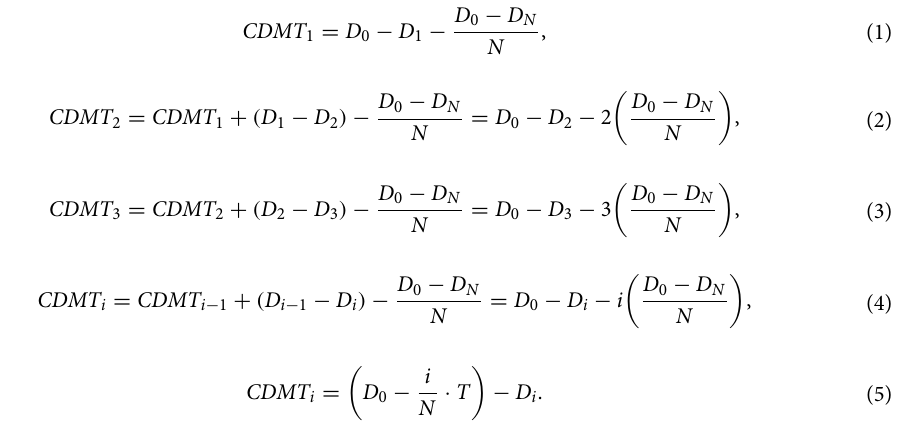
Sea-level change and Fischer plot. Relative sea level is defined as the height of geoid minus the solid rock or sediment surface height. Relative sea level changes are equal to the difference between the changes in sea surface height and solid surface height which create eurybatic and eustatic sea-level changes respectively 14–16 . Eurybatic sea-level changes in an ocean basin are always local, while eustatic sea-level changes are usually syn- chronous in regional, and could be theoretically correlated between ocean basins and even in global scale 14–16 . Relative sea-level oscillations generate changes of new accommodation spaces 17 , which could be filled by pro- duction of carbonate sediment, and consequently create variable thicknesses of sedimentary cycles in the shal- low-marine carbonates. Therefore, after deducting a constant (minus average cycle thickness) to remove the solid rock subsidence, which is assumed changeless, the subsidence-corrected cumulative variable thickness of sedimentary cycles could represent eustatic sea-level changes 1,2,18,19 . So, new accommodation spaces being filled and a near-linear or constant subsidence are necessary assumptions for Fischer plots to define eustatic sea-level changes. However, the assumption for near-linear or constant subsidence usually cannot be determined, so Fis- cher plots are considered to indicate the changes of accommodation space (i.e., relative sea-level changes repre- sented as the sum of subsidence and eustasy) in many studies 19 . Thus, we suggest that it is necessary to estimate whether a Fischer Plot indicates eustatic sea-level changes or relative sea-level changes based on its geological settings and data in the specific research case. In the original concept of Fischer plots, the cumulative cycle thickness, which minus average thickness (vertical axis), was mapped onto a diagram in the time scale (horizontal axis) to illustrate sea-level changes (Fig. 1A) 2,20 . However, it is unlikely to ensure all sedimentary cycles in a stratigraphic record were formed over the absolute time interval, so that the horizontal axis of Fischer plots has been modified to cycle number (time domain) or stratum thickness (depth domain) (Fig. 1B,C). The vertical axis has been modified to a subsidence- corrected value labeled “Cumulative Departure From Average Cycle Thickness (CDMT)” 1,18 . The value of the CDMT at any cycle should be the difference between accumulation of each cycle thickness from the first cycle to the current one and average cycle thickness. During the period of sea-level rise, Fischer plots show a positive excursion in vertical axis and vice versa. The algebraic formula (5) for calculating CDMT was introduced 1 , and here we present the derivation process of this formula: